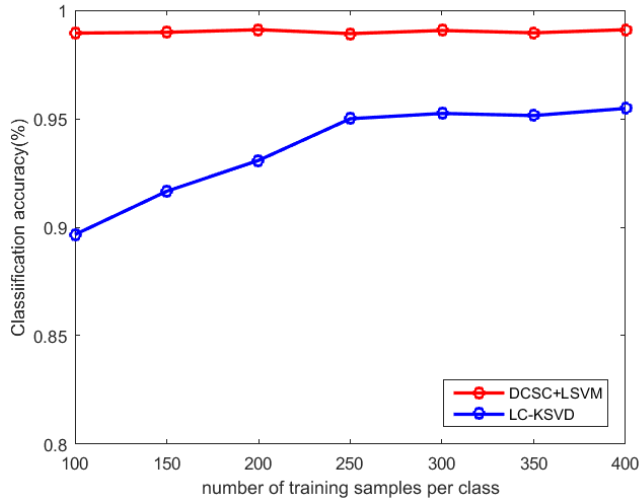
Figure 8. Classification accuracy based on different numbers of training samples per class.